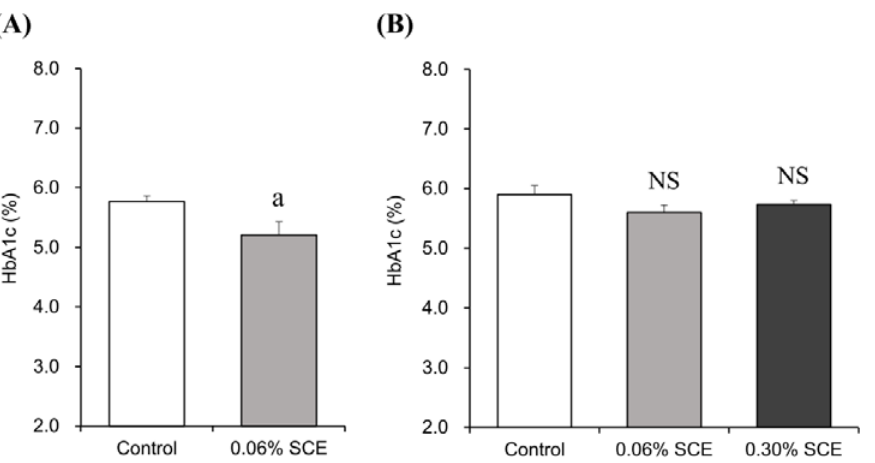
Figure 3. Effects of chronic administration of SCE on HbA1c levels in ( A ) AIN93M purified ( B ) AIN93M/Glc diet-fed KK-A y mice. Values are means ± SEM ( n =